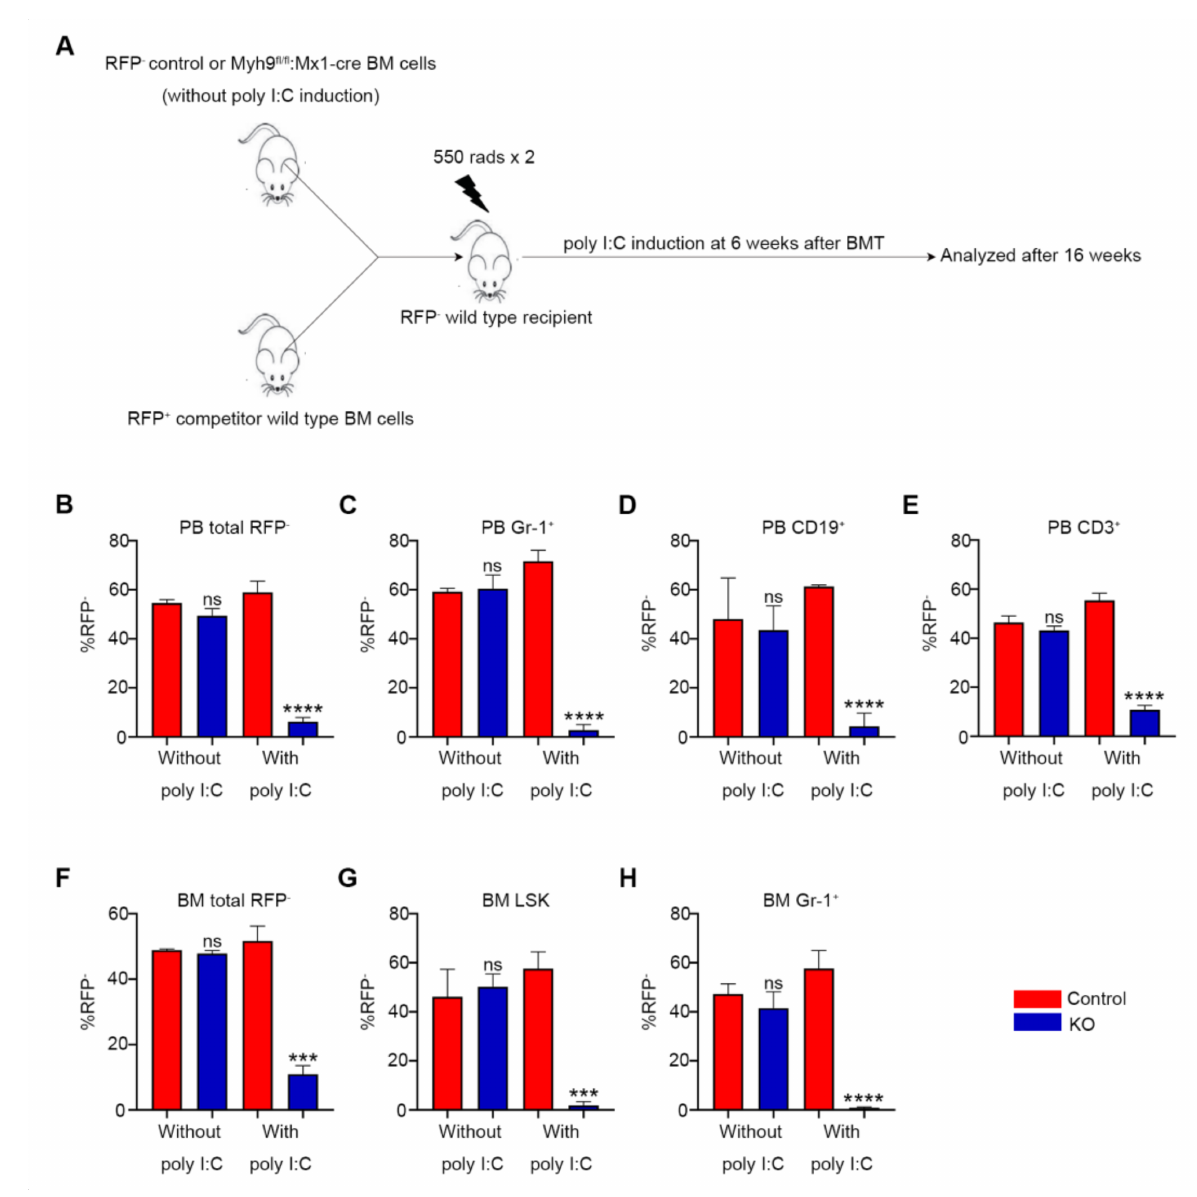
Figure 4. Myh9 deficiency impairs repopulation capacity of HSC. ( A ) Schematic diagram of bone marrow competitive reconstitution assay. BM cells (5 × 10 5 ) from uninduced RFP - Myh9 fl/fl :Mx1-cre or littermate control mice were mixed with RFP + wild type mice BM cells (5 × 10 5 ) at a 1:1 ratio and transplanted into lethally irradiated RFP - recipient mice. Six weeks after BMT, recipient mice were treated with three doses of poly I:C to delete Myh9 after hematopoietic reconstitution. The recipient mice were analyzed at 6 weeks after BMT and 16 weeks after poly I:C injection. Bar graphs show the percentage of donor derived RFP - cells ( B ), percentage of RFP - Gr-1 + myeloid cells ( C ), percentage of RFP - CD19 + B cells ( D ), percentage of RFP - CD3 + T cells ( E ) in the peripheral blood of recipient mice at 6 weeks after BMT (without poly I:C) and 16 weeks after poly I:C injection (with poly I:C). The percentage of donor derived RFP - cells ( F ), RFP - LSK cells ( G ), RFP - Gr-1 + myeloid cells ( H ) in the BM of recipient mice at 16 weeks after poly I:C injection (n = 3–4). All data are shown as mean ± SD. Student t test was used to compare two groups of mice (*** p < 0.001, **** p <